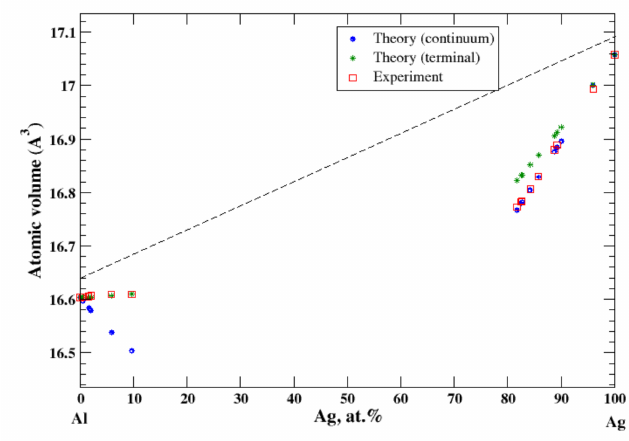
Figure 1. Atomic volume vs. concentration for Al-Ag alloy system. The experimental data are from Ref. [16] (p. 261 and p. 351).